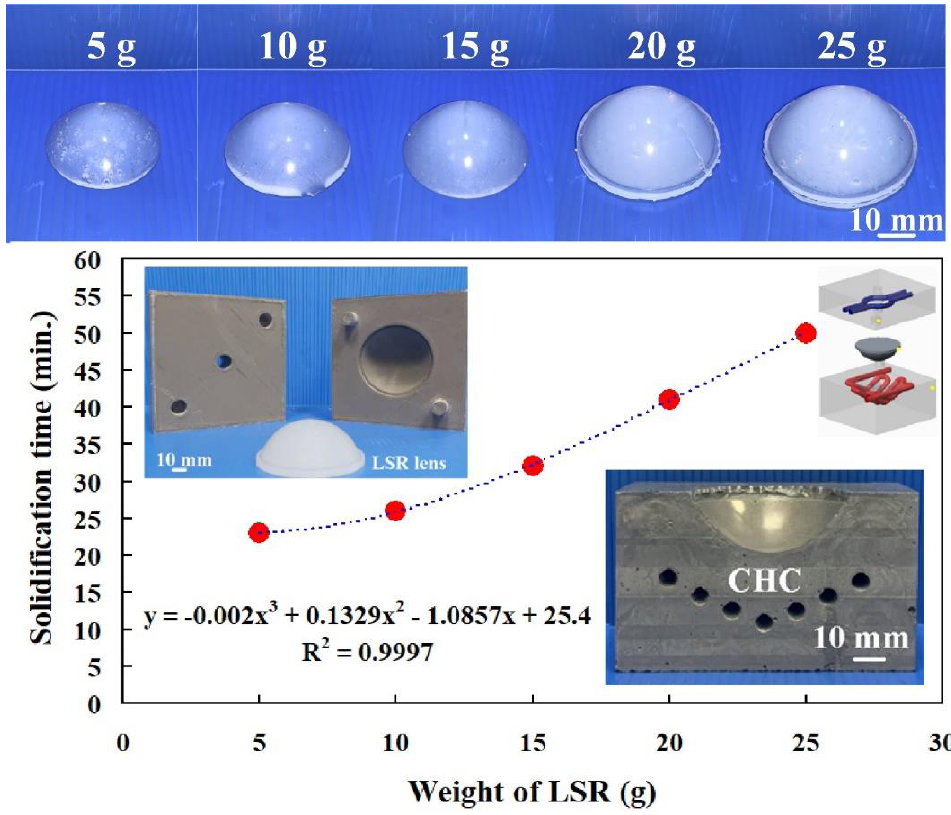
Figure 11. Solidification time of a convex lens for different LSR